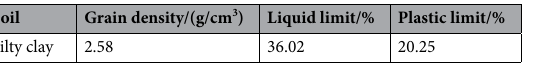
Table 1. Basic physical properties of the soil